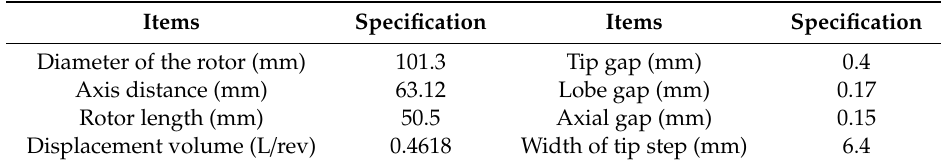
Figure 1. Physical model of Roots blower at crank angle 10 ◦ and 100 ◦ . Table 1. The main geometrical parameters of the Roots